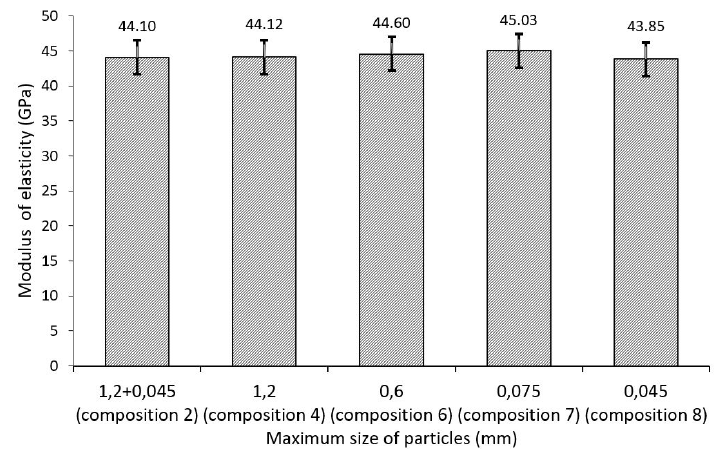
Figure 8. Influence of the maximum aggregate size in RPC elasticity modulus– Phase